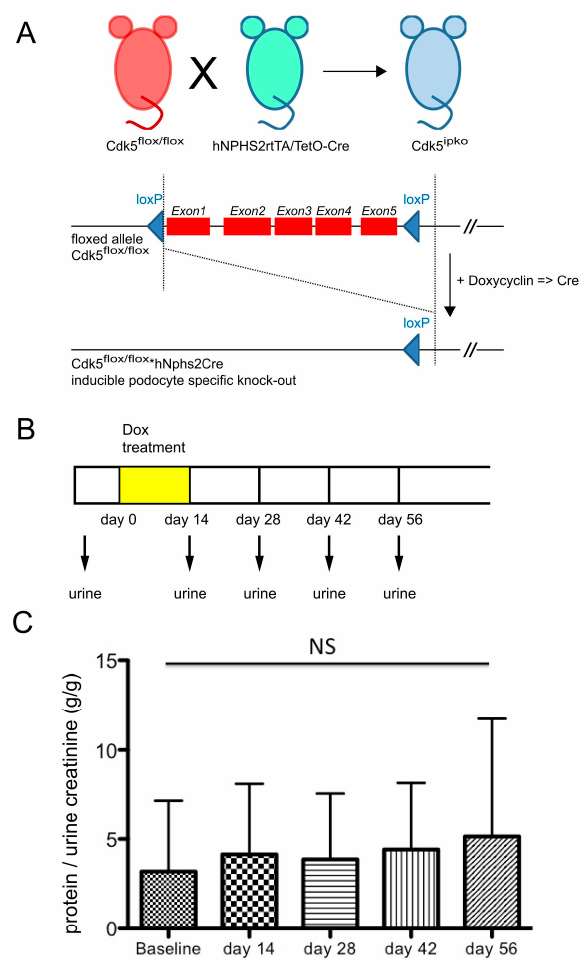
Figure 3. Mating scheme of inducible podocyte-specific knockout of Cdk5 and baseline characteriza- tion. ( A ) Cdk5flox/flox mouse mated to hNPHS2rtTA/TetO-Cre yields podocyte-specific doxycyline- inducible deletion of the Cdk5 gene (Cdk5 ipko ). ( B ) Schematic representation of doxycycline adminis- tration (14 days) and urine sampling in mice of 8–10 weeks of age. ( C ) Urine protein/creatinine ratio ( g / g ), followed over 56 days after initiation of doxycycline, is stable within normal limits. n = 6. Experimental glomerular disease was induced after doxycycline-dependent Cdk5 knockout by intraperitoneal injection of nephrotoxic serum (NTS) in mice 10 weeks of age (Figure 4A). Histological analysis and quantification of proteinuria were performed on day 7 after induction of glomerular disease. PAS- and AFOG-staining revealed glomerular sclerosis in Cdk5 ipko as well as control animals (Figure 4B). Glomerular scarring was greater in Cdk5 knockout compared to control animals (mean grade Cdk5 ipko : 1.79